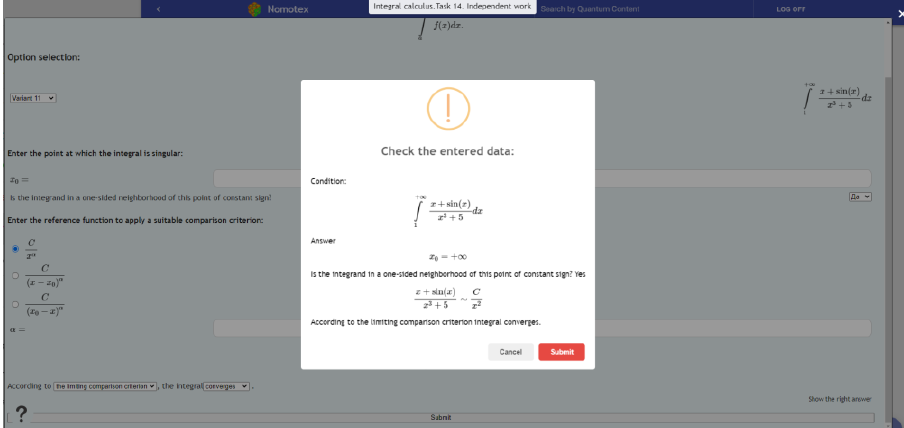
Fig. 6a. Entering the answer in the DLS